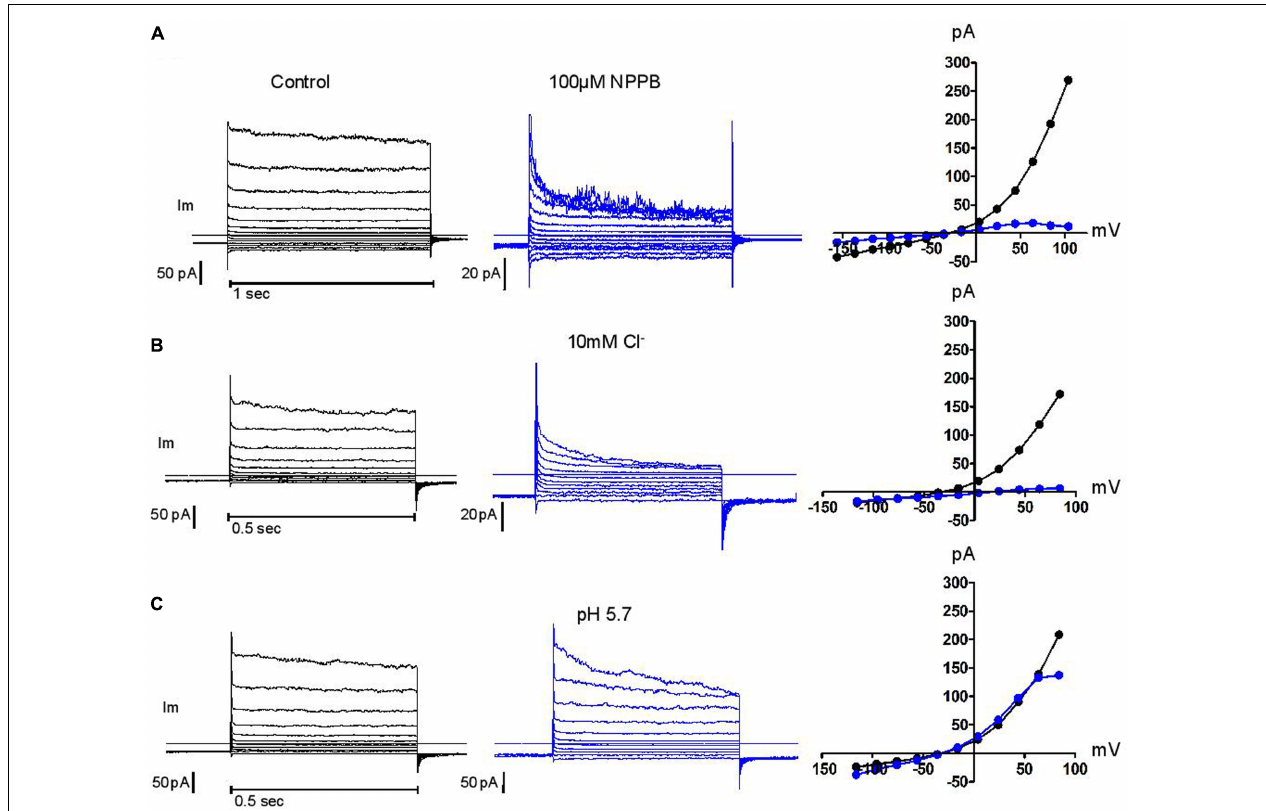
FIGURE 5 | Control of current inactivation in HVCN1 – / – neutrophils by NPPB 100 µ M, a Cl – channel inhibitor (A) , reduced Cl – concentration (10 mM, B ) and low external pH (pH 5.7, C ): each emphasizes the inactivation of the outwardly rectifying Cl – current at high membrane potentials. Experiments were carried out in solution set E ( Table 1